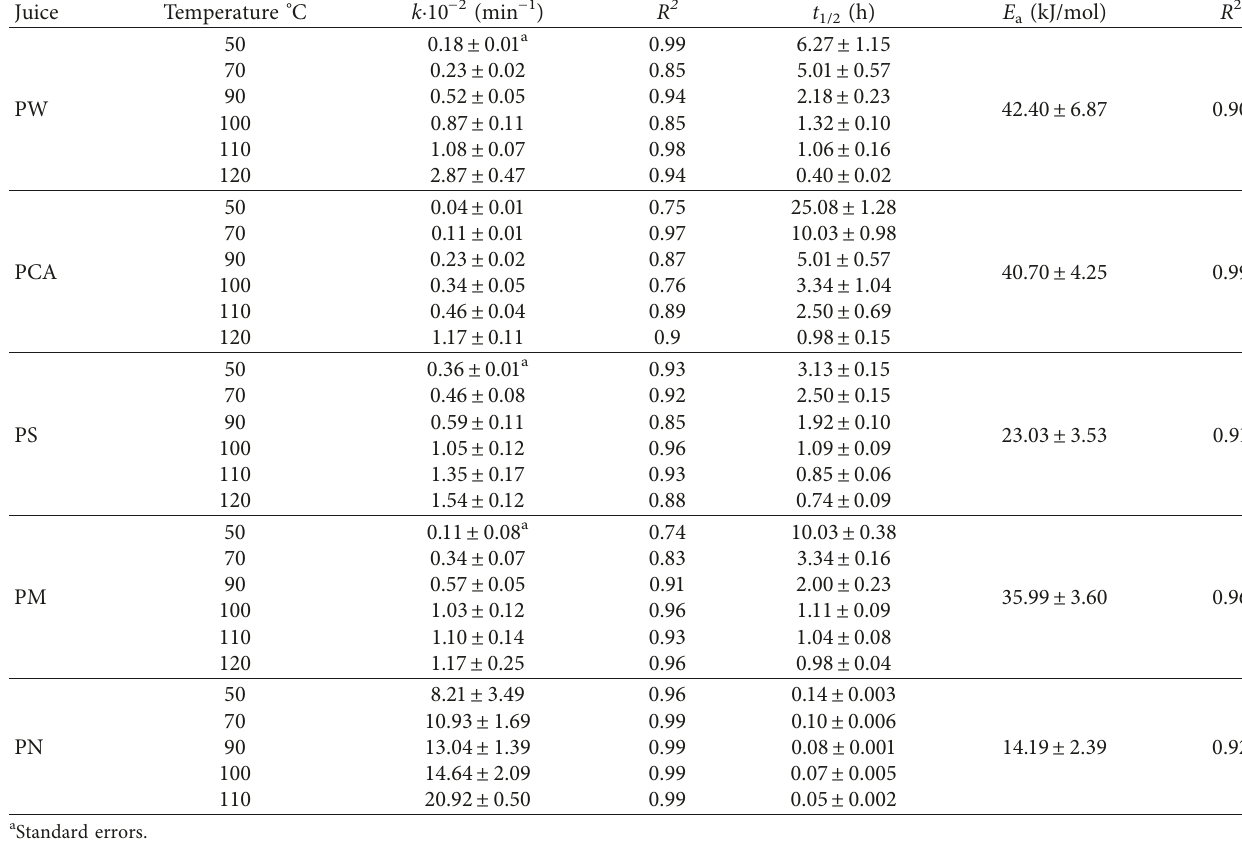
a ) of anthocyanins thermal degradation in plum juices.